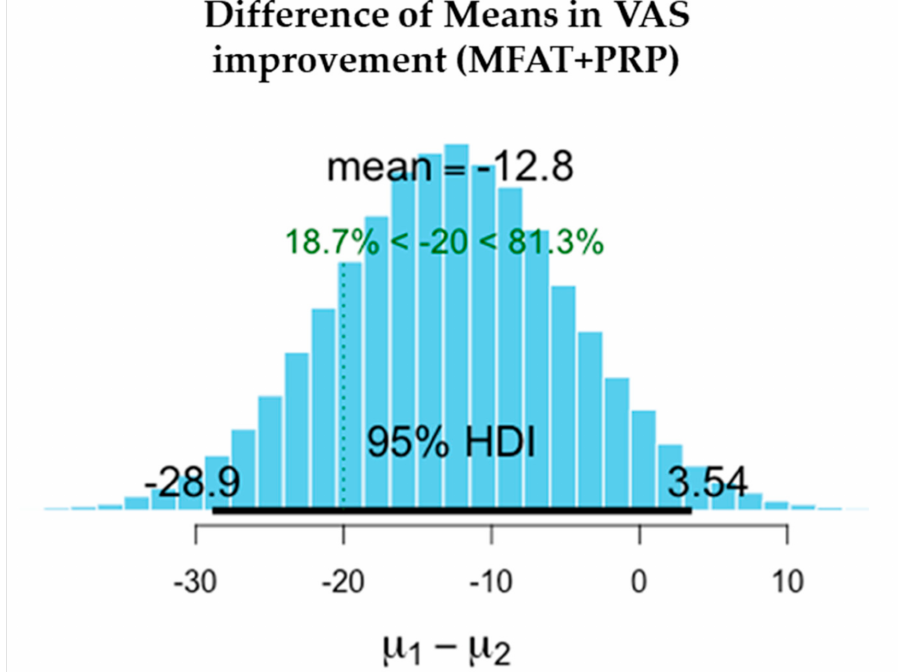
Figure 7. Demonstrates the difference of the means between the pre-treatment ( µ 2 ) and 1 year post treatment ( µ 1 ) VAS for MFAT + PRP. This shows the 95% credible interval between − 28.882 and +3.543. The super-responder threshold of − 20 is marked the dotted green